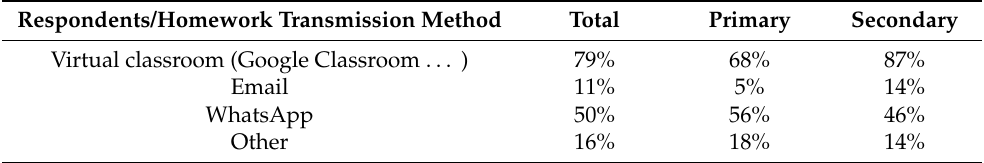
Table 14. Homework transmission method used during the COVID 19 pandemic (question